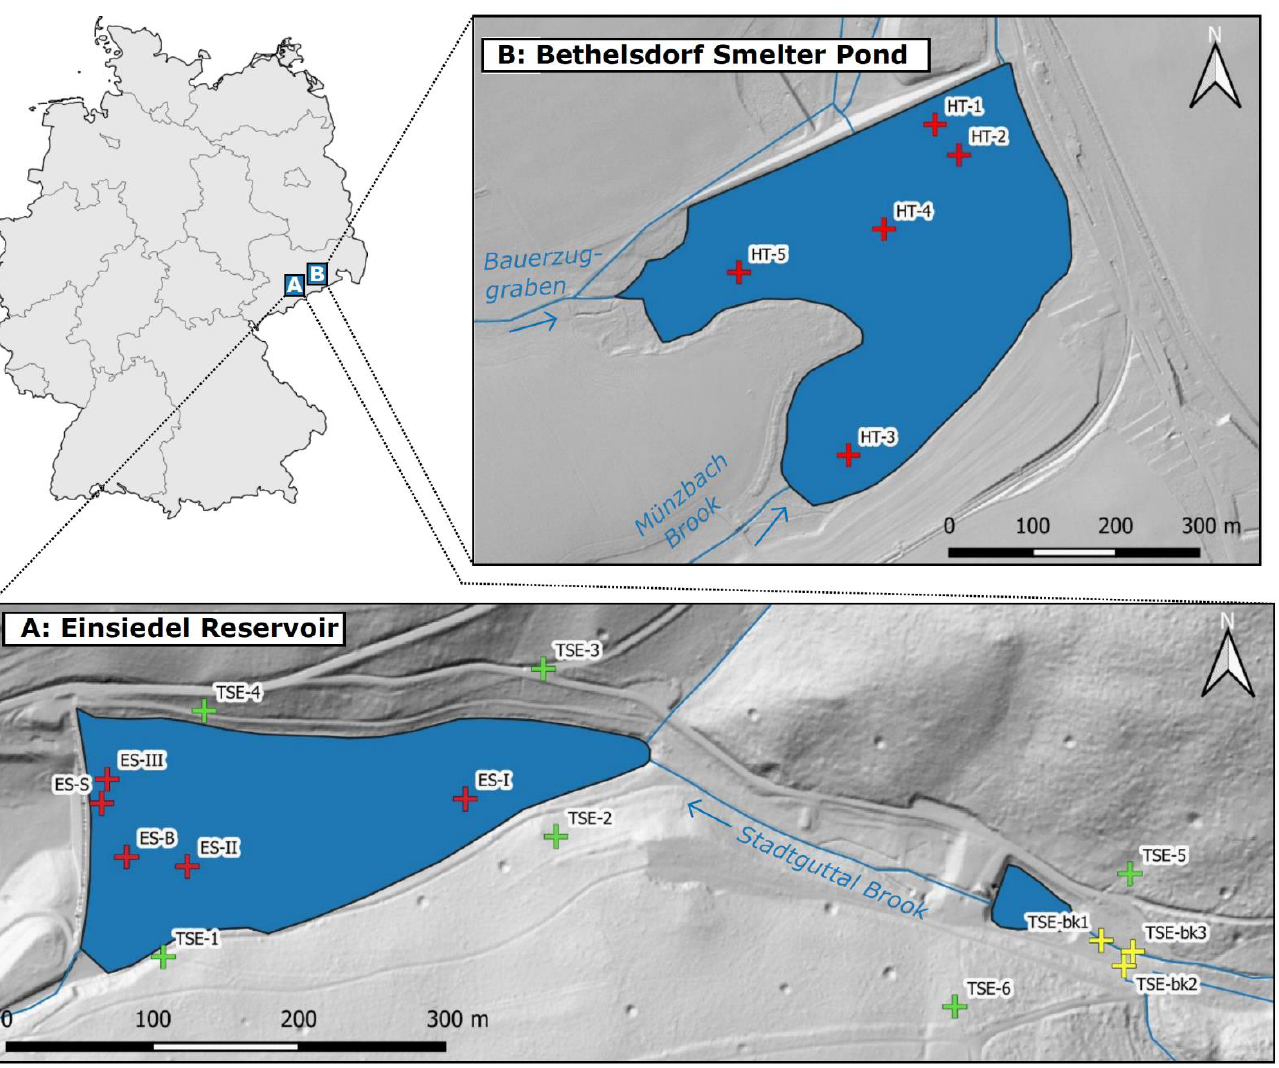
Figure 2. Hillshaded digital elevation models (DEM) of the ( A ) Einsiedel Reservoir and of the ( B ) Berthelsdorf Smelter Pond (BSP) with sampling points (red—reservoir sediments; green—soil samples; yellow—tributary brook sediments). Maps by T. Beier via QGis; source of DEMs and water bodies: Staatsbetrieb Geobasisinformation und Vermessung Sachsen (GeoSN; dl-de/by-2-0) [35,36].